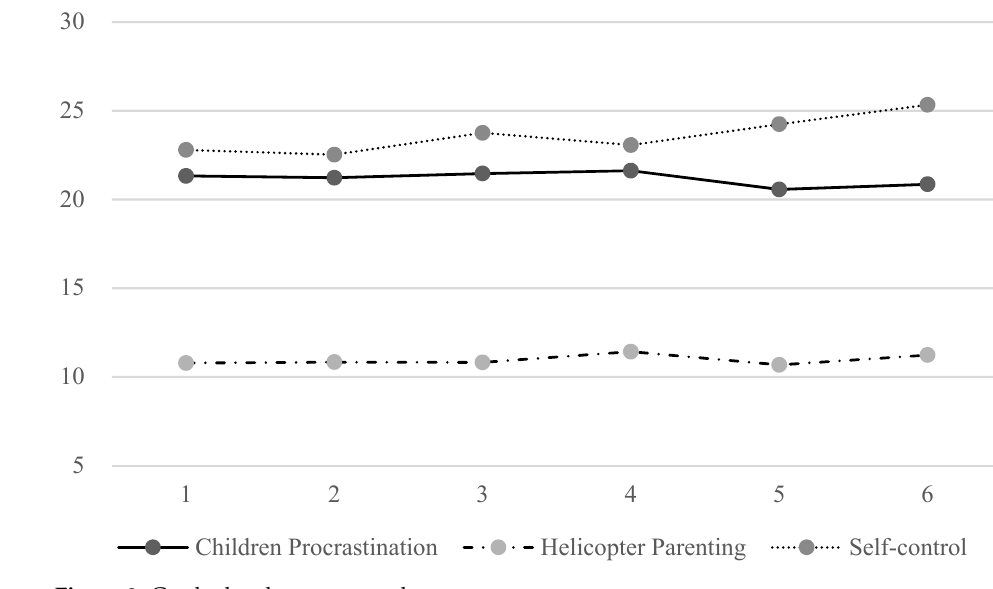
Table 2. Independent t -test between boys and girls.